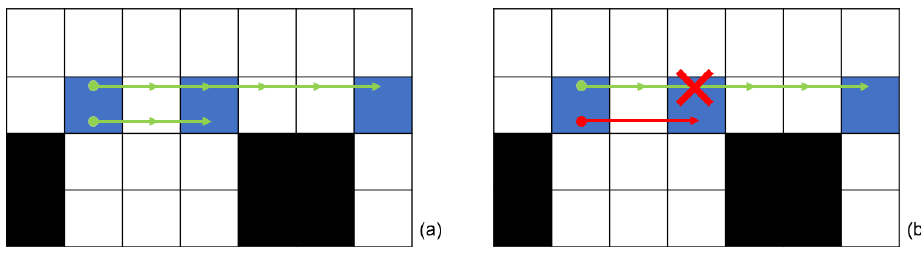
Figure 9. Avoiding the creation of duplicate paths. ( a ) Scenarios that allow duplicate paths between nodes on a straight line; ( b ) detection of duplicate paths during path creation.